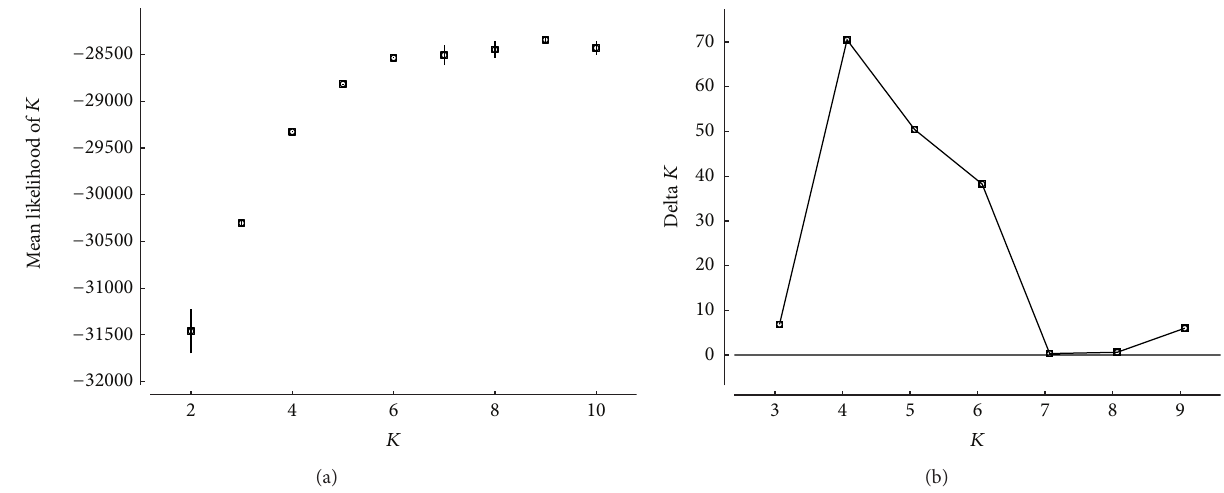
Figure 2: Methods for estimating the most appropriate number of genetic clusters ( 𝐾 ) testing 𝐾 = 2 to 𝐾 = 10 for 556 individuals from six Eucalyptus species. (a) The mean likelihood of 𝐾 ( ± SD) showing a plateau in the likelihood surface at 𝐾 = 6 and (b) Δ𝐾 methods showing significant genetic groupings at 𝐾 = 4, 5, and 6. This genetic clustering of multilocus genotypes was undertaken in STRUCTURE with no a priori species